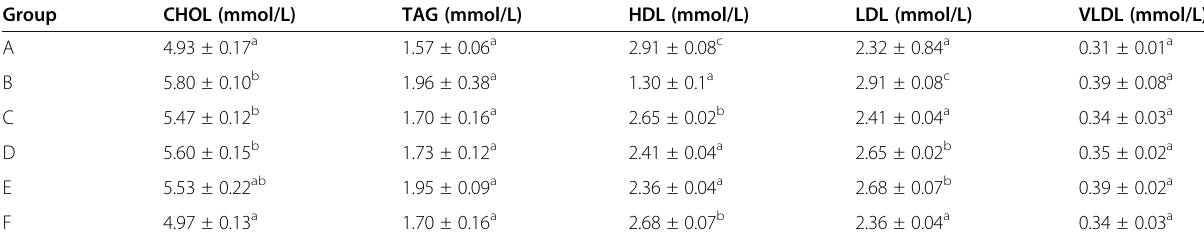
Superscripts a, b and c indicate significant difference at P<0.05 down the columns (across the groups). CHOL Cholesterol, TAG Triacylglycerol, HDL High Density Lipoproteins, LDL Low Density